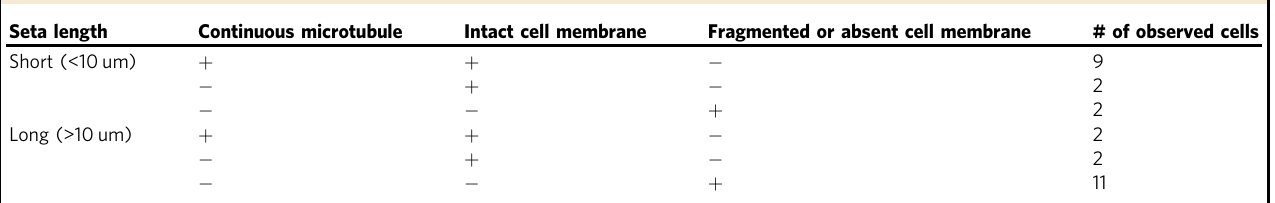
Fig. 3 3D structure of actively growing seta. a A low-magni fi cation cryoTEM image of vitri fi ed C. tenuissimus cells. The thick cell bodies are indicted with (*). The middle cell has two fully formed setae (green arrowheads) and two shorter, presumably forming, setae (purple arrowheads). b A high- magni fi cation cryoTEM projection image of the tip of a forming seta. c , d 2D orthogonal views through the 3D reconstructed tomogram of a forming seta. e Volume rendering of the different components of a growing seta: The microtubule is in green, intracellular vesicles in yellow, cell membrane in red, silica cell wall in blue, and external layer in gray. f 3D view of the silica cell wall and external layer only. g , h 3D views of the silica cell wall and cell membrane only. i Zoom in on a slice through a 3D data set, demonstrating the structural difference between the lipid bilayer membrane of the cell (in red) and the envelope external to the cell wall (yellow arrowhead); silica is indicated by (*). See Supplementary Movie 1 for an animation of the 3D reconstruction. Table 1 The structural characteristics of analyzed